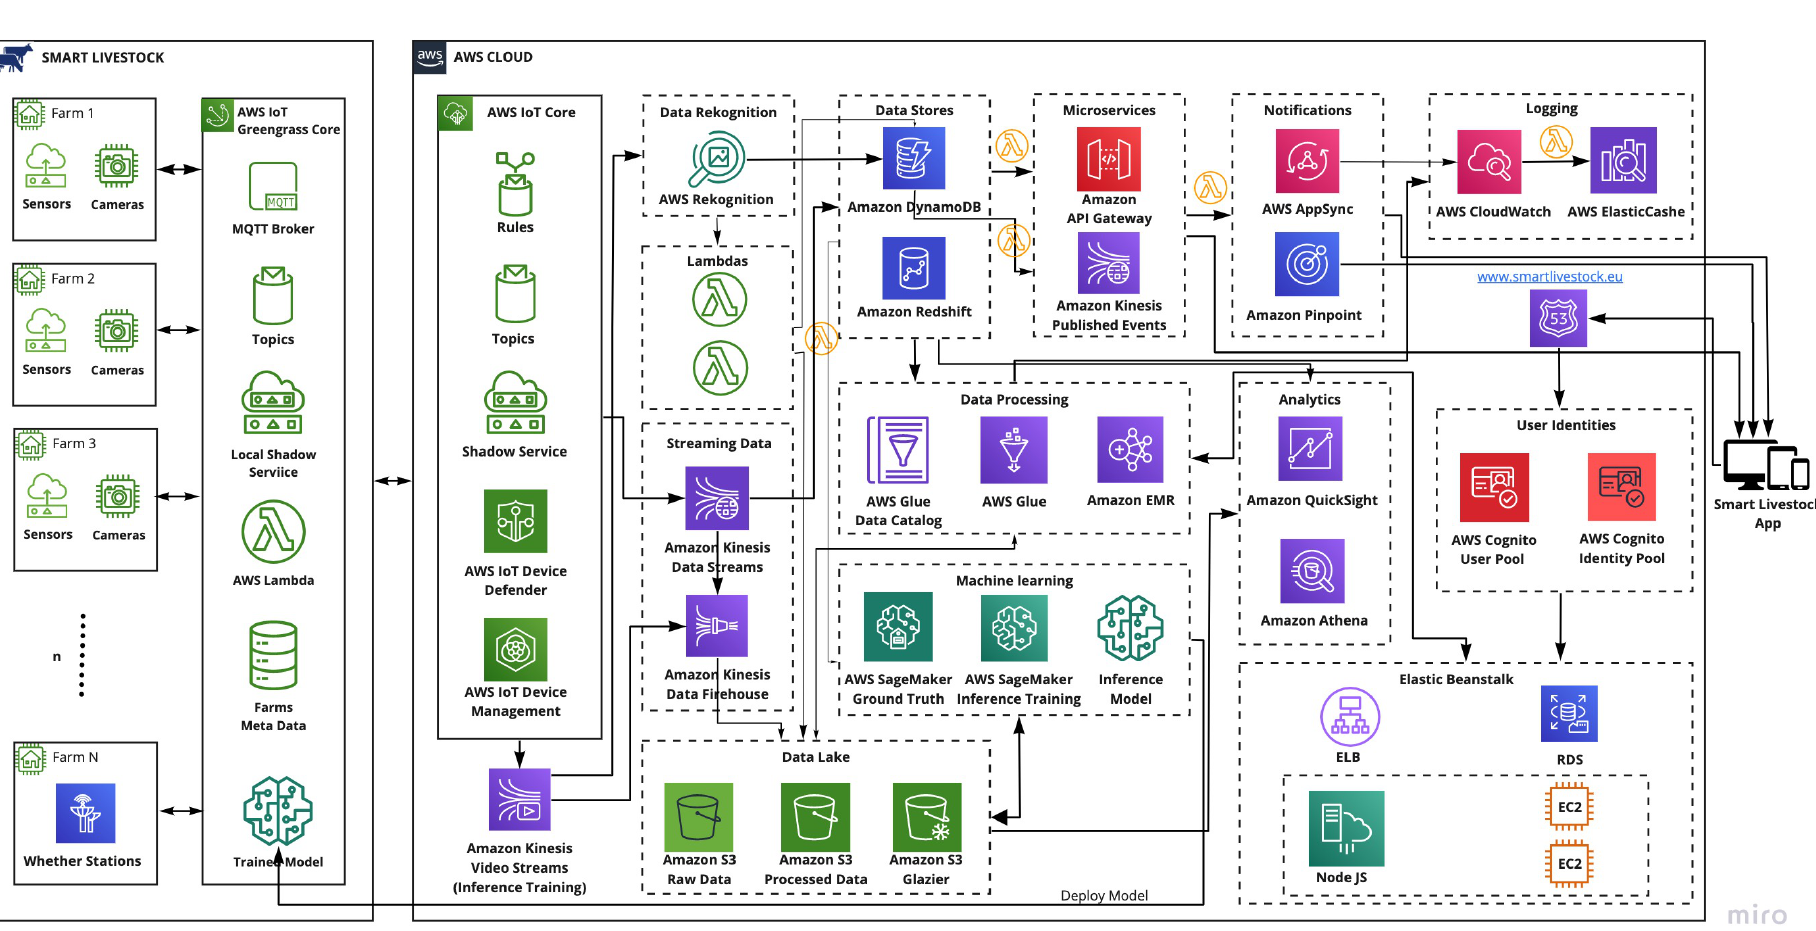
Figure 2. Architecture design for livestock smart farming. (https://www.smartlivestock.eu/, accessed on 20 May